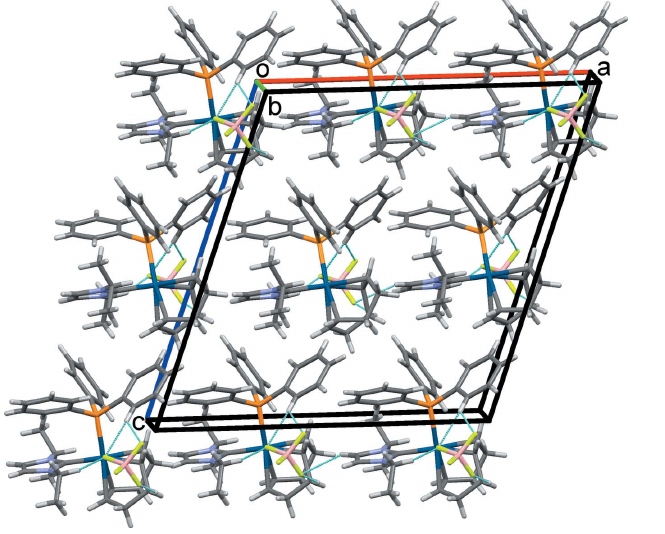
Figure 2 The unit cell viewed along the crystallographic b axis.